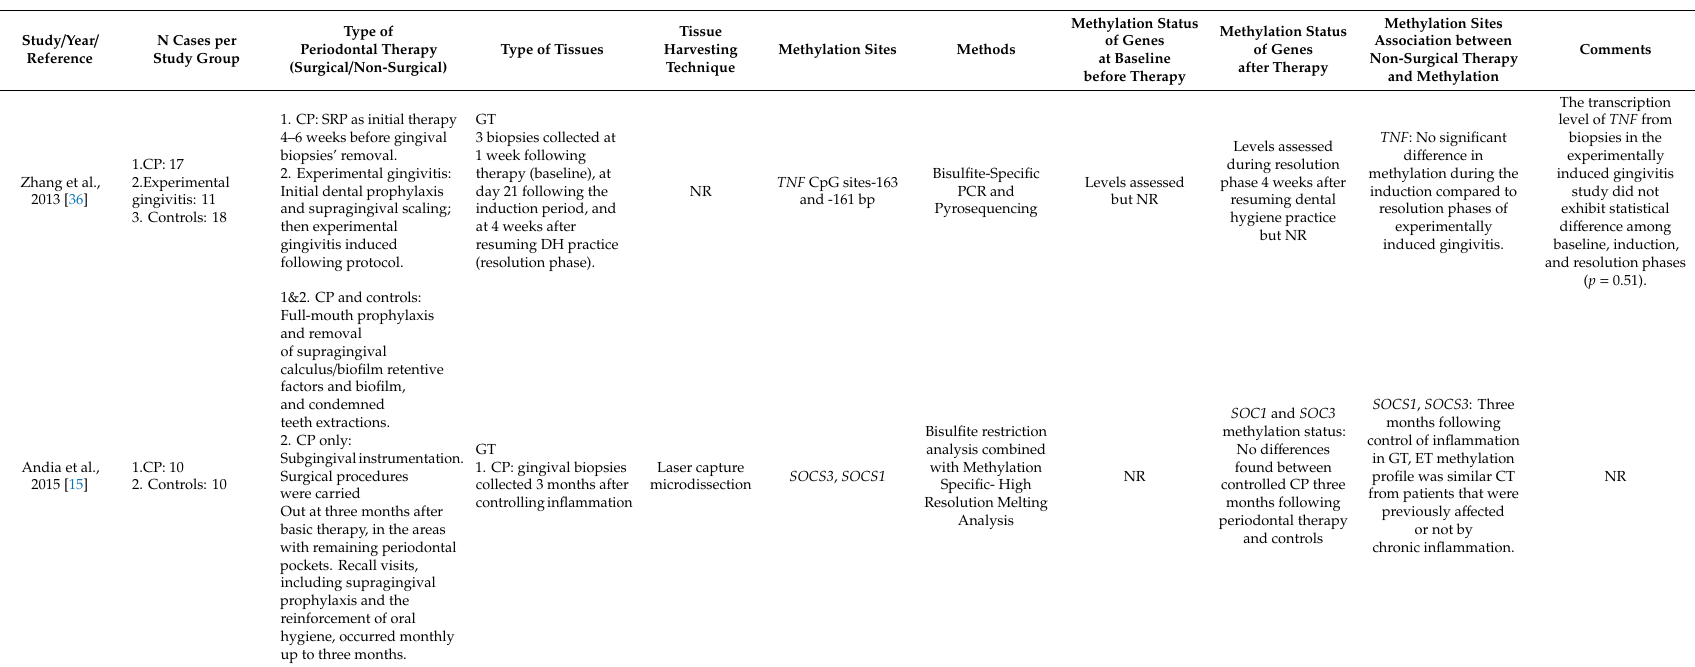
Table 4. Specific gene methylation after periodontal